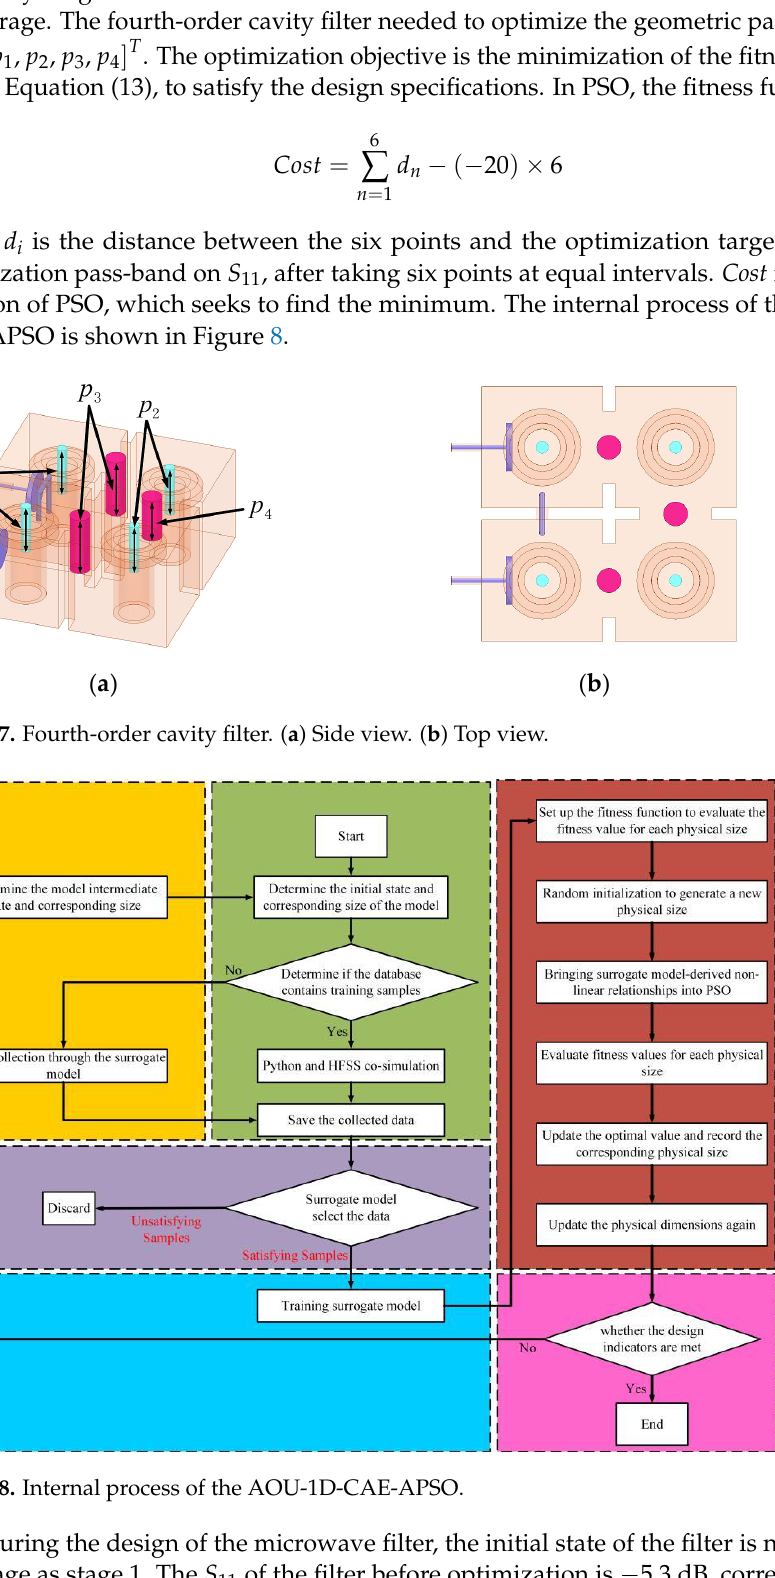
Figure 9. Fourth−order cavity filter HFSS verification of the optimized response in PSO iterations. ( a )−( e ) Reflection coefficient 21 S . Firstly, add training samples. This paper proposes an optimized design method that only uses a co-simulation of python and HFSS for the first data collection. More data is obtained by disturbing the geometrical parameters, as in Equation (14),